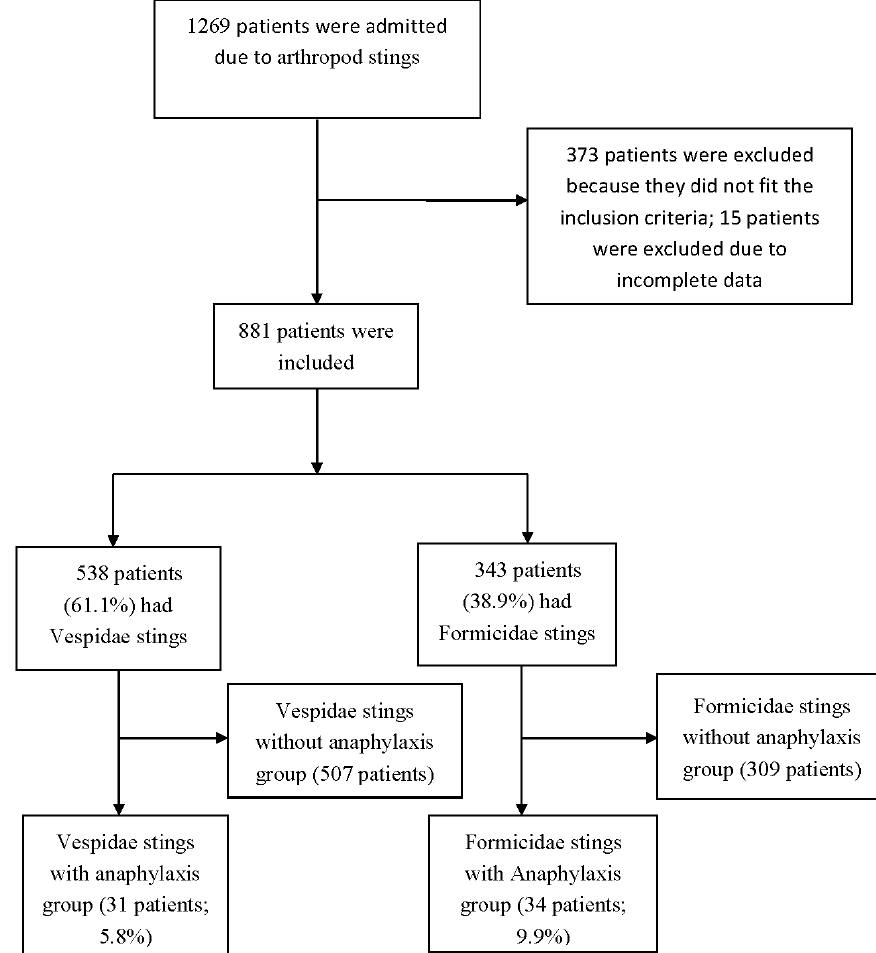
Figure 1. The structure of the research and division into groups.